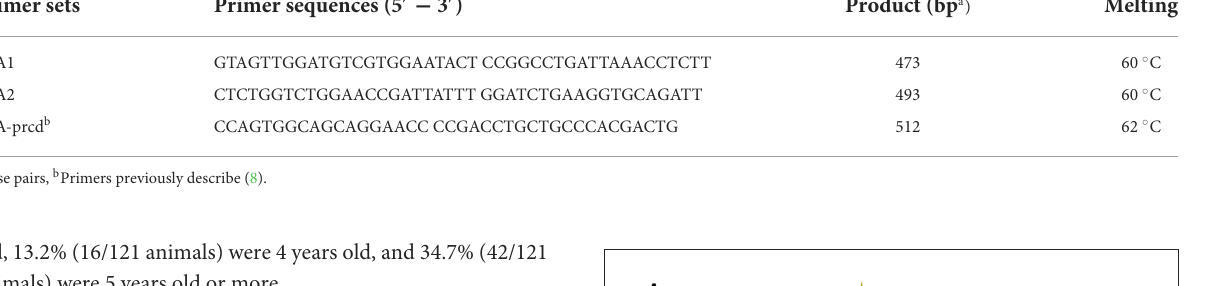
TABLE 1 PCR and sequencing primer sets used in this study. Primer sets